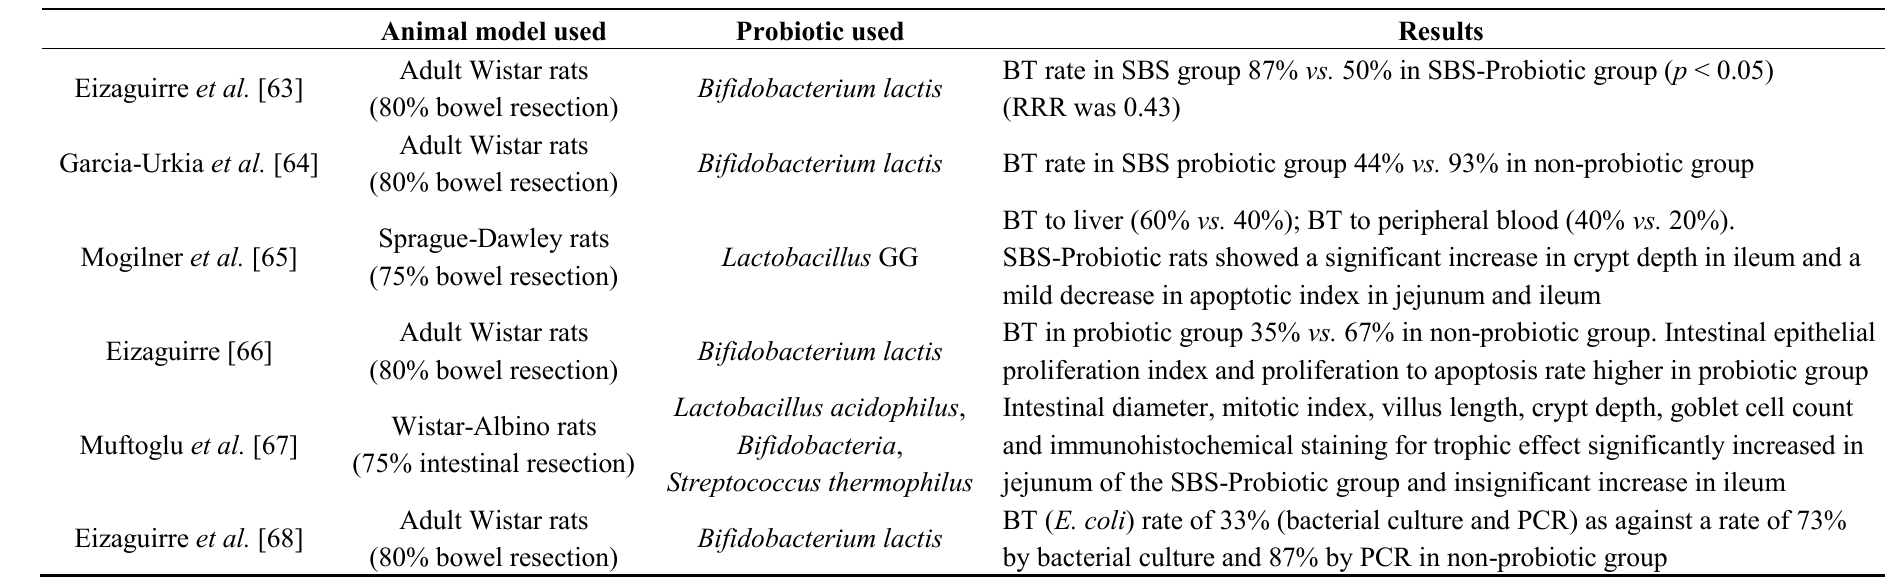
Table 1. Experimental studies in animal models of short bowel syndrome (SBS) investigating the effect of probiotics.